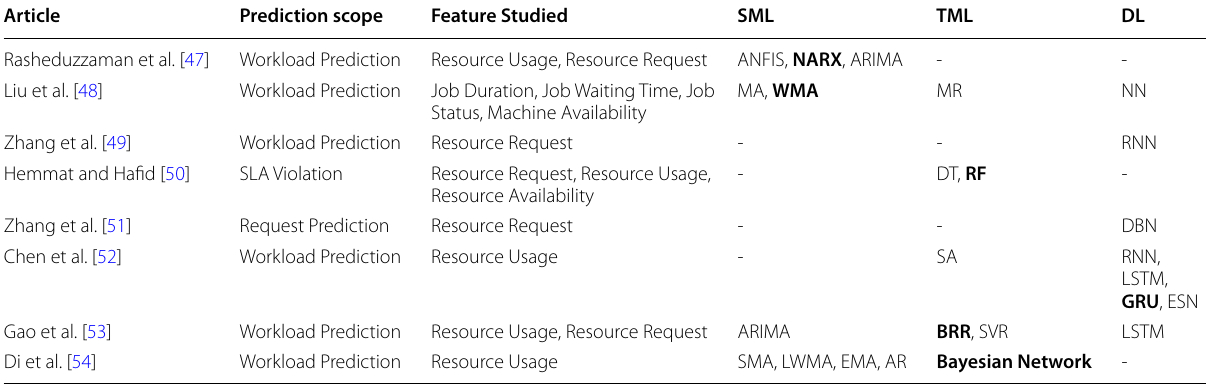
Table 10 This table presents the related works of other kind of prediction using GCT dataset. The algorithm in bold refers to the best model mentioned in the respective article. [Note: SML ‑ Statistical Machine Learning Algorithms, TML ‑ Traditional Machine Learning Algorithms, DL ‑ Deep Learning